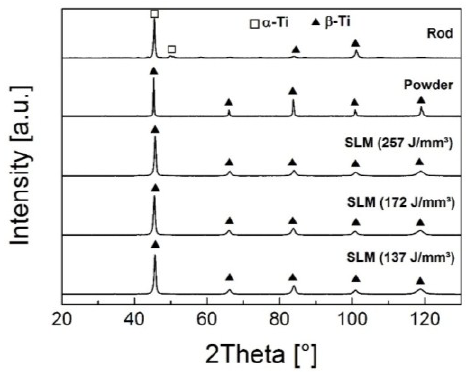
Figure 2. X-ray diffraction patterns of the initial Ti-45Nb rod, the gas atomized powder and of bulk samples produced by SLM with different energy input.